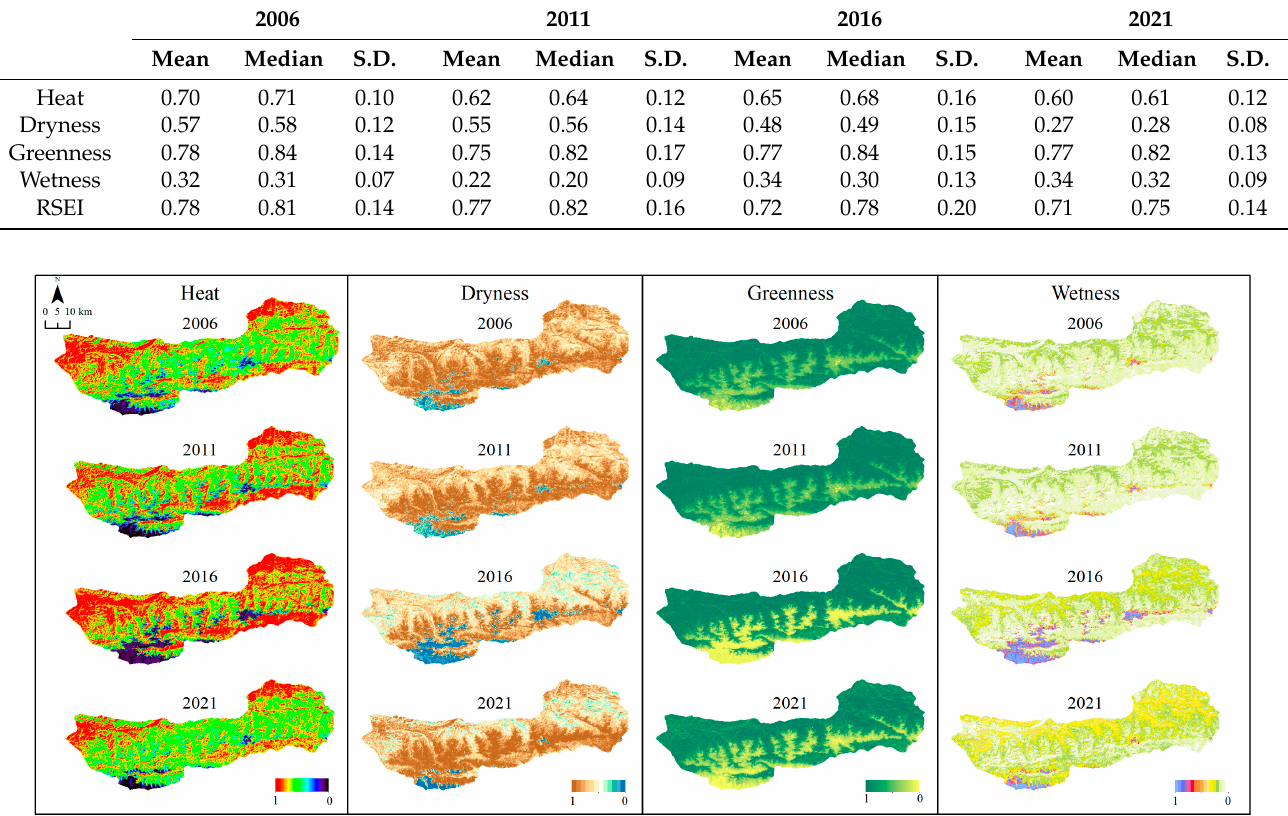
Figure 3. Normalized index of heat, dryness, greenness and humidity from 2006 to 2021. The four-year RSEI values in 2006, 2011, 2016 and 2021 were 0.78, 0.77, 0.72 and 0.71, respectively (Figure 4b). The results show that the mean RSEI values in the study site from 2006 to 2021 showed a significant decreasing trend, but the decreasing trend was slow. The distribution of RSEI values in the study area from 2006 to 2016 was above 0.60, the distribution below 0.4 increased in 2016, and the distribution in the range of 0.40–0.60 increased in 2021. Since 2016, there has been a significant downward trend in the ecosystem quality in the study site, but it has maintained a more stable state. The fluctuations are relatively